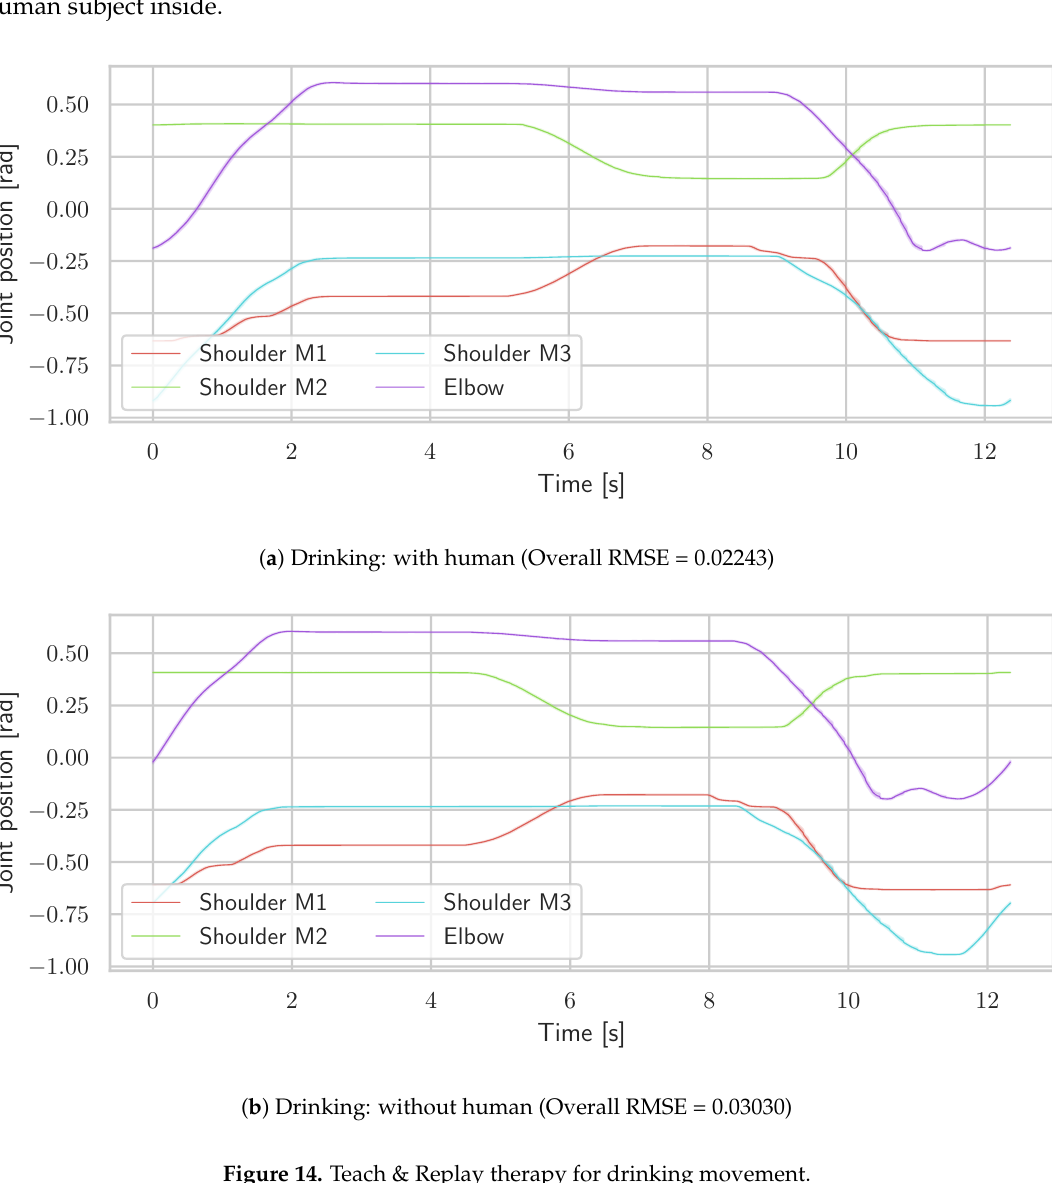
Figure 14. Teach & Replay therapy for drinking